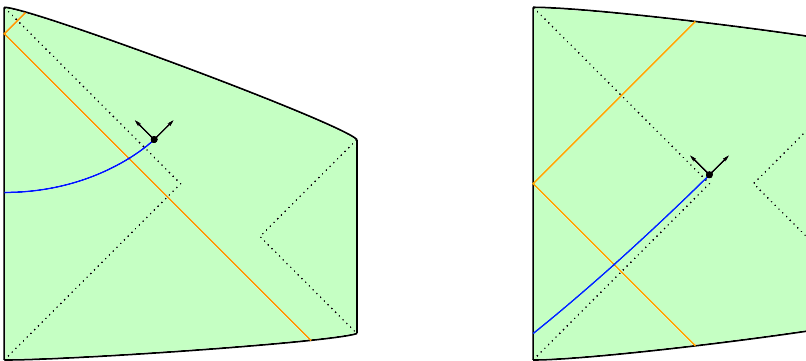
Figure 13 . A spherical null shell in the BTZ geometry. In the left diagram we adopt a frame where the shell (shown in orange) reflects off of the left boundary at some late time, while on the right diagram we boost to a frame where it reflects near t = 0 . We are interested in the excitation − energy of a massless particle produced at the end of the blue dressing geodesic, in particular when the shell has nonzero ˆ T as in equation